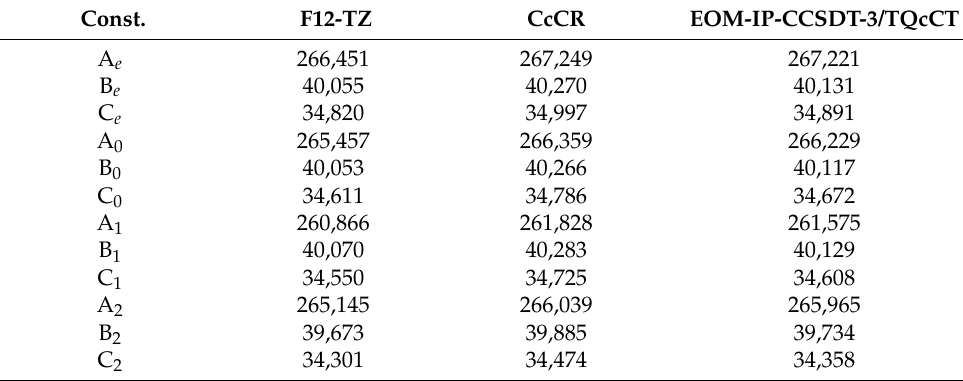
Table A5. ˜X 2 B 1 H 2 CO + Rotational